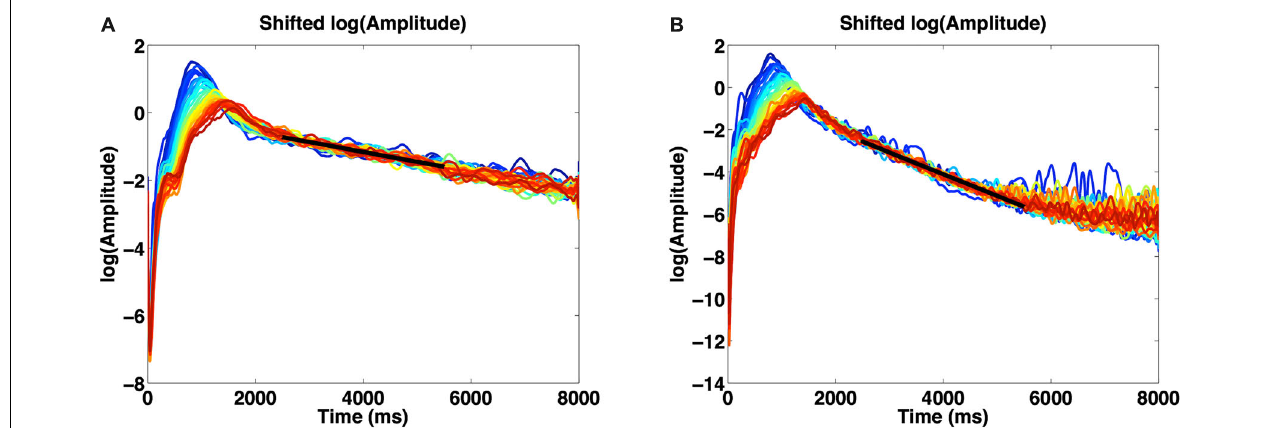
FIGURE 7 | Logarithm of the incoherent amplitude at all available distances as a function of time. The curves show an almost linear trend in the coda. The left panel corresponds to the lowest frequency band (A) , the right one to the highest frequency band (B) . The time scale in Figure is milliseconds (ms).